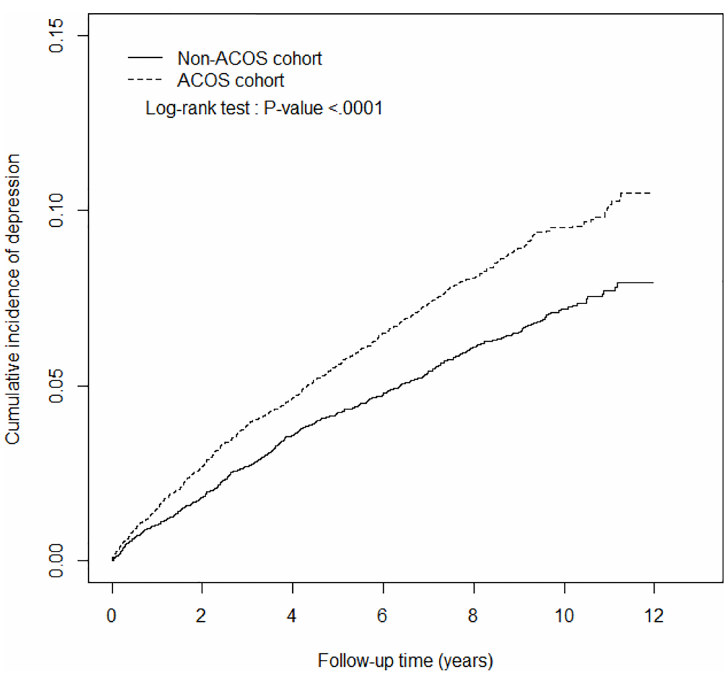
Fig 1. Cumulative incidence of depression in the ACOS (dashed line) and non-ACOS cohorts (solid line). ACOS, asthma–COPD overlap syndrome; COPD, chronic obstructive pulmonarydisease.